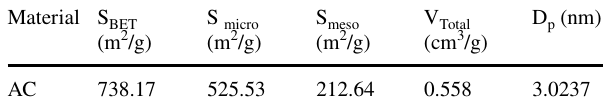
Table 2 BET analysis results for activated carbon Material S BET (m 2